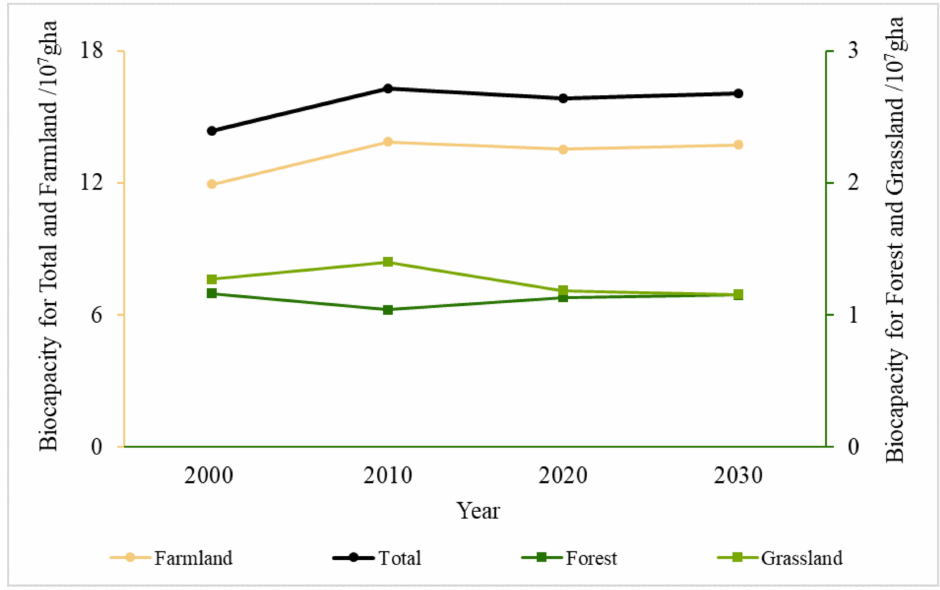
Figure 5. Change tendency of BC in the Agro-Pastoral Zone of Northern China from 2000 to